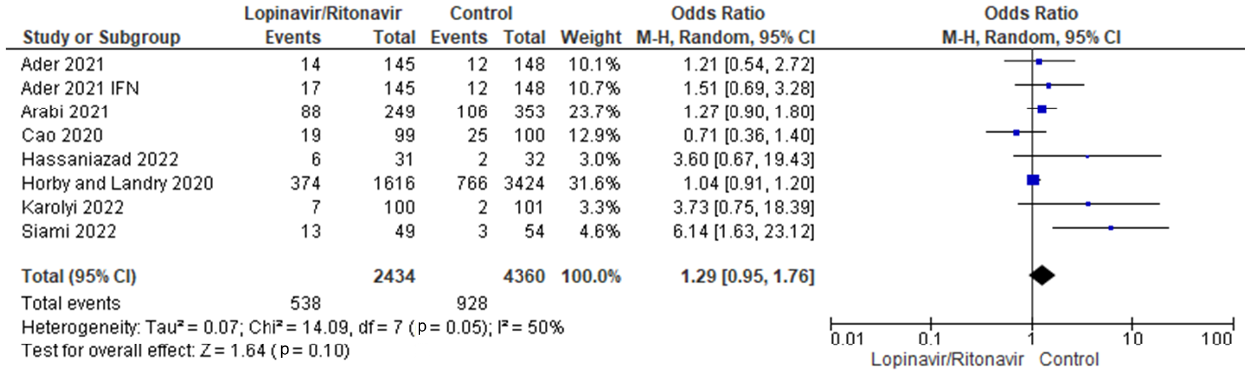
Figure 2. Quality assessment of the included studies. ( A ) Risk-of-bias graph. ( B ) Risk-of-bias summary for each study.